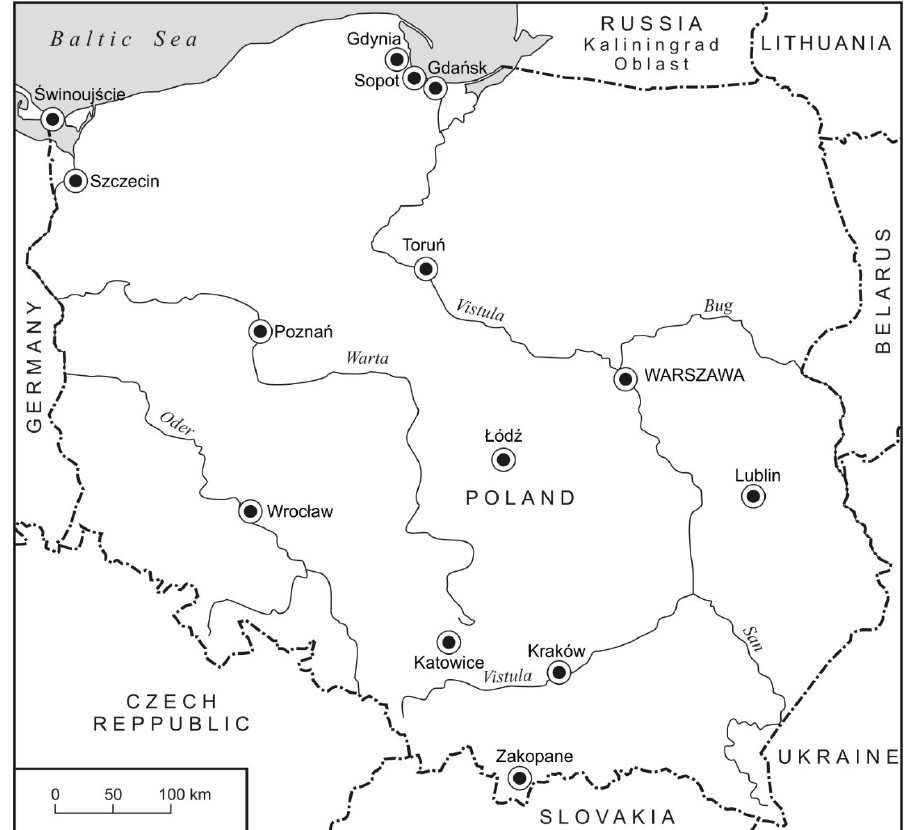
Figure 1. Map of Poland with the locations of the cities studied.